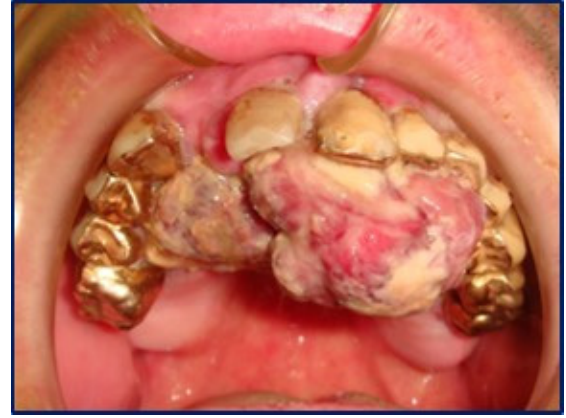
Figure 1. Rapidly growing lesion of the hard palate with periodontal involvement, with a red- yellowish appearance.